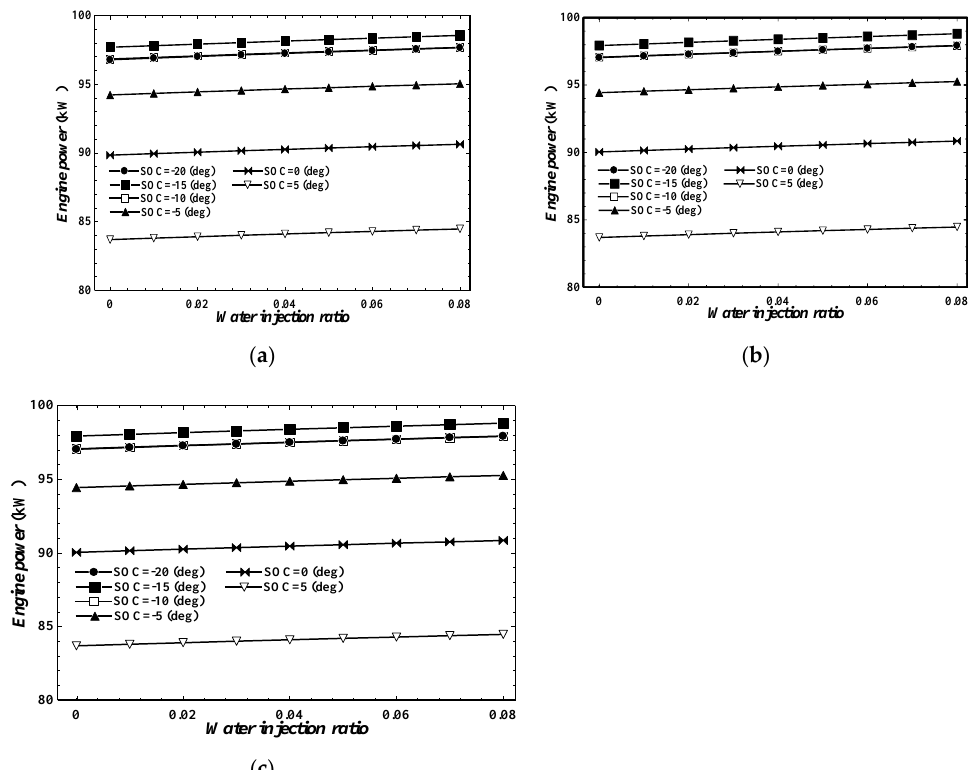
Figure 13. Engine power in various water injection ratios and start of combustion angles for gasoline ( a ), E5 ( b ) and E10 ( c ).